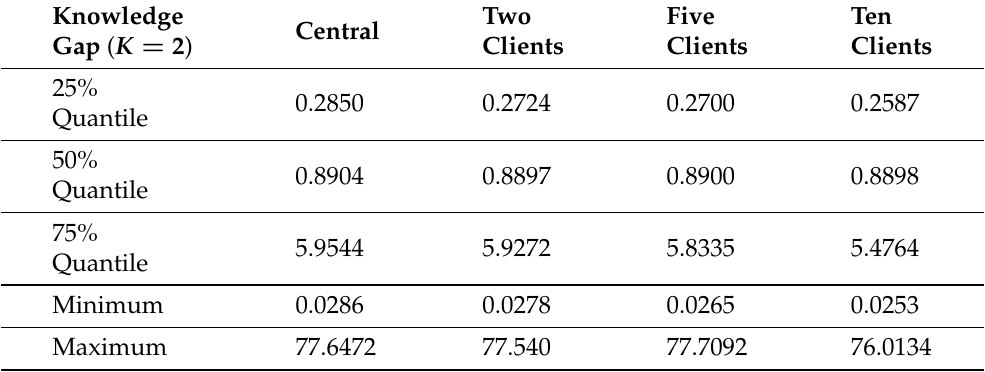
Table 6. Statistics of the knowledge gap on the 100 G2 test sets with k -means